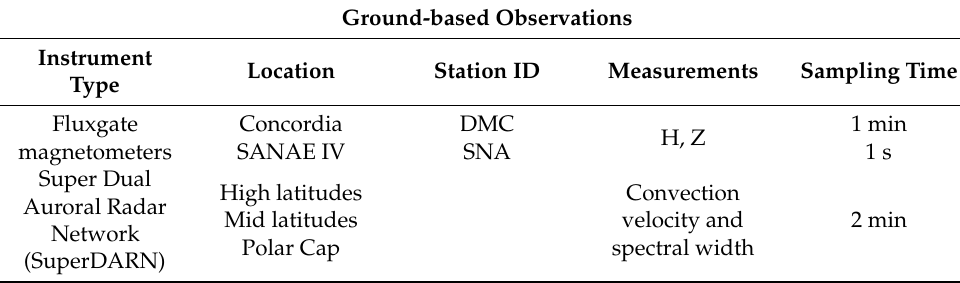
Table 3. Instrument type, location, station identifier, measurements and sampling time of the ground- based observations used in this